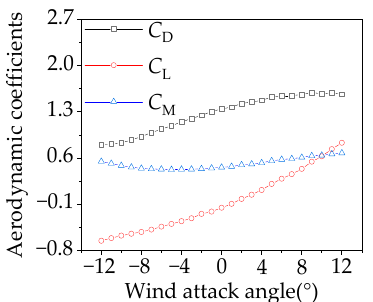
Figure 5. The distribution of aerodynamic coefficients with a wind attack angle.